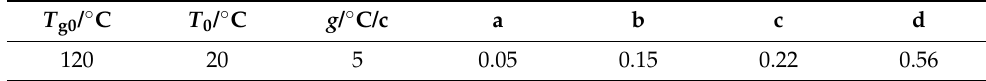
Table 3. Empirical constants